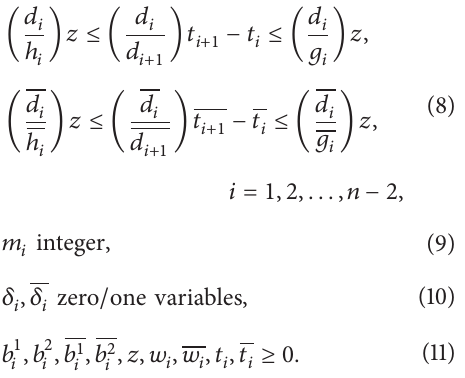
Figure 4: Time-space diagram of green band from